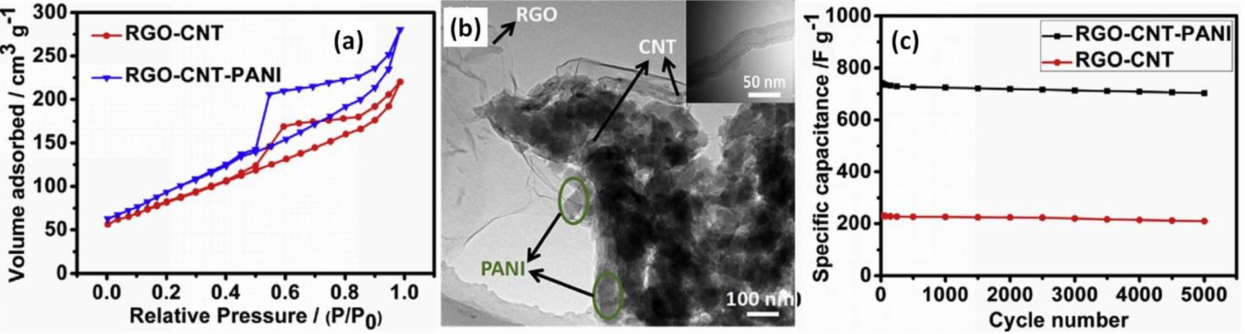
Figure 4. The N 2 adsorption/desorption isotherms of rGO-CNT-PANI and rGO-CNT materials ( a ). TEM images of rGO-CNT-PANI ( b ), with CNT nanofibers presented in the inset. Cycling performance of the rGO-CNT-PANI and rGO-CNT electrodes at a scan rate of 10 mV/s ( c ) (Reprinted from [59], Copyright 2017, with permission of Elsevier).